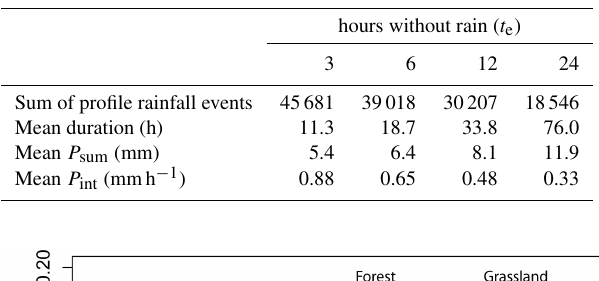
Table 2. Rainfall event characteristics over all 135 profiles depend- ing on minimum hours without rain ( t e ) required between consecu- tive rainfall events.